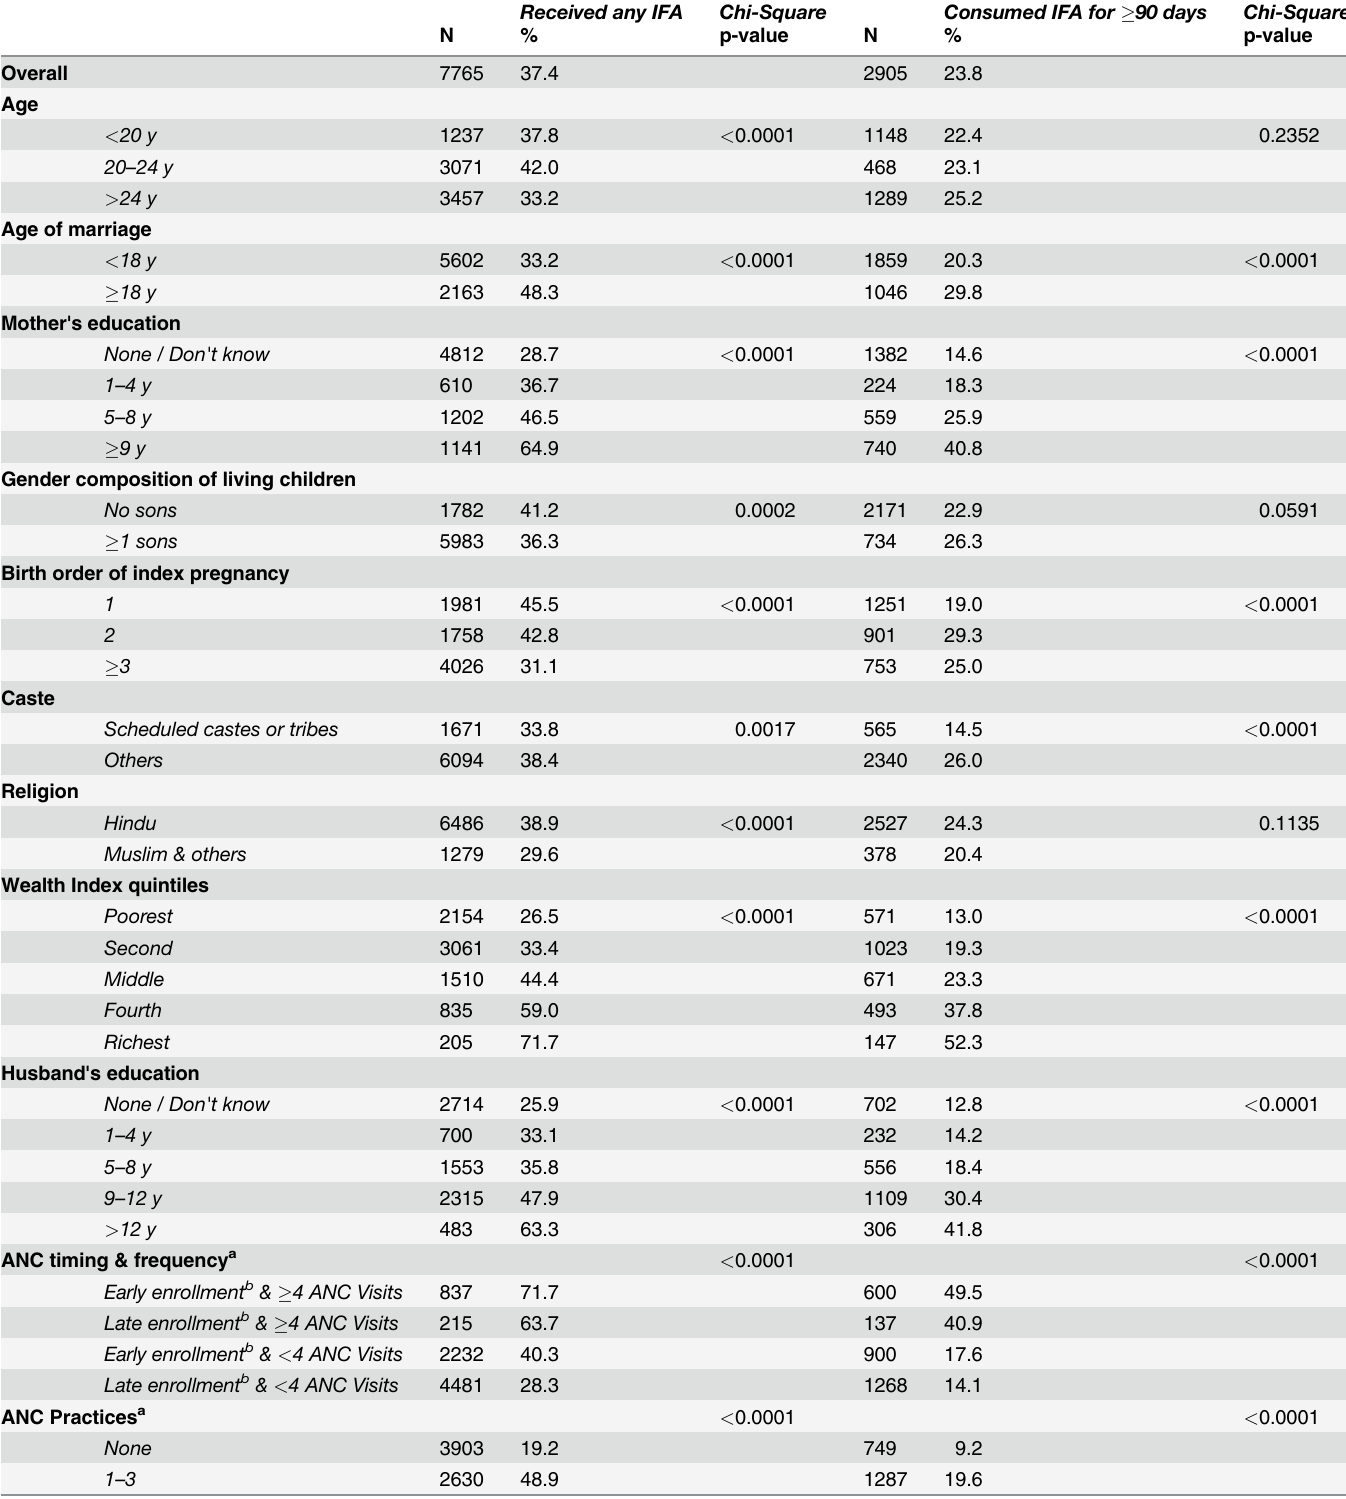
Table 4. Individual-level factors of study population by prevalence of iron and folic acid receipt and